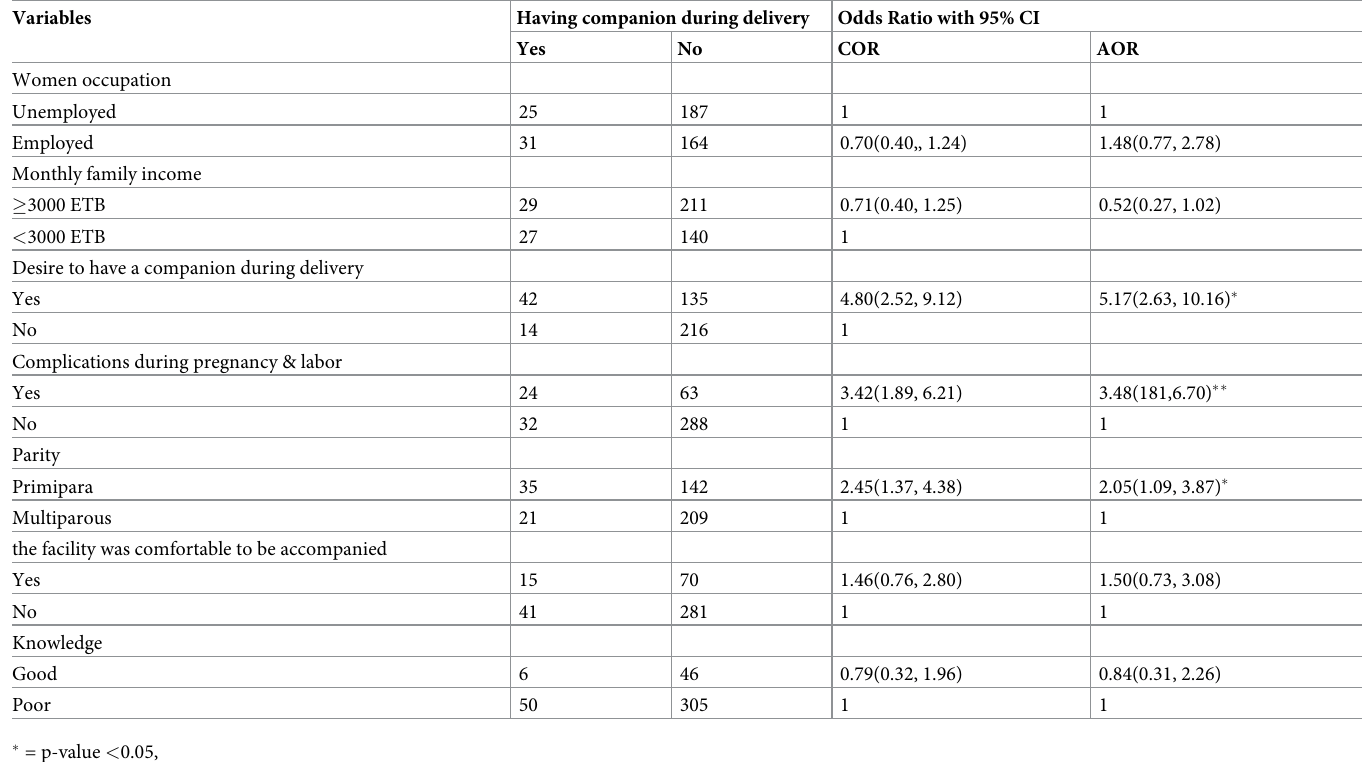
Table 3. Bivariate and multivariable analysis of factors associated with utilization of companion during delivery, Arbaminch Ethiopia, Feb 2019 (n =